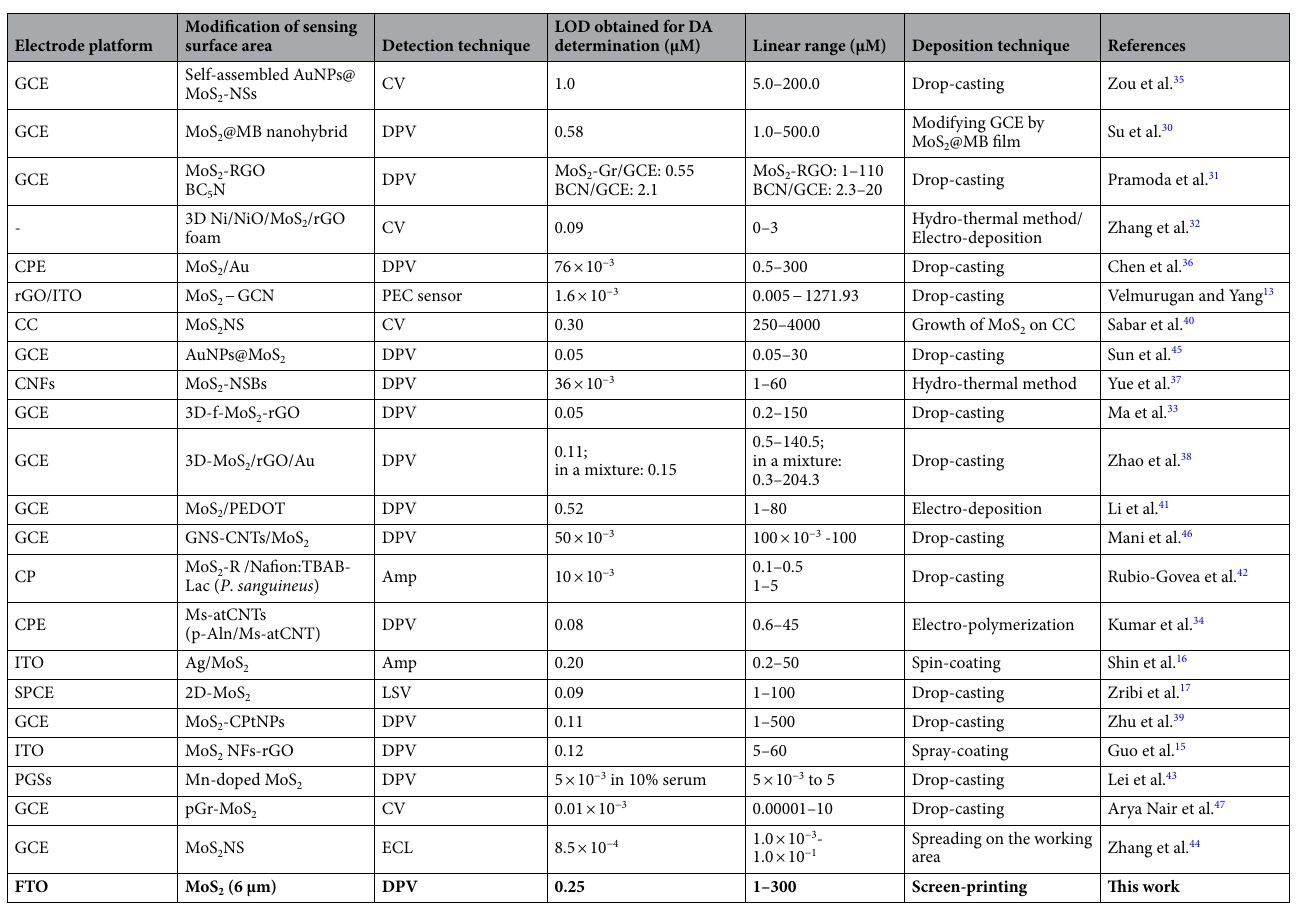
Table 2. Comparison of analytical performance of various DA electrochemical sensors depending on sensing platform modification, detection and deposition technique. Ag/MoS 2 Silver encapsulated MoS 2 hybrid nanoparticle, Amp. Amperometry, AuNPs Gold nanoparticles, BC 5 N Borocarbonitride, CC Carbon cloth, CV Cyclic voltammetry, CPE Carbon paste electrode, CP Carbon paper, DA Dopamine, ECL